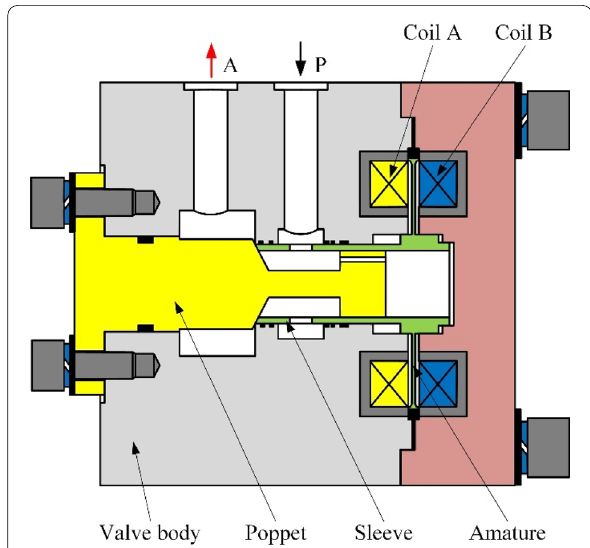
Figure 5 Moving-sleeve type poppet valve developed by Gu et al.